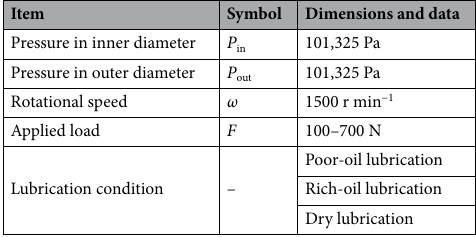
Table 2. Operating conditions during tests.